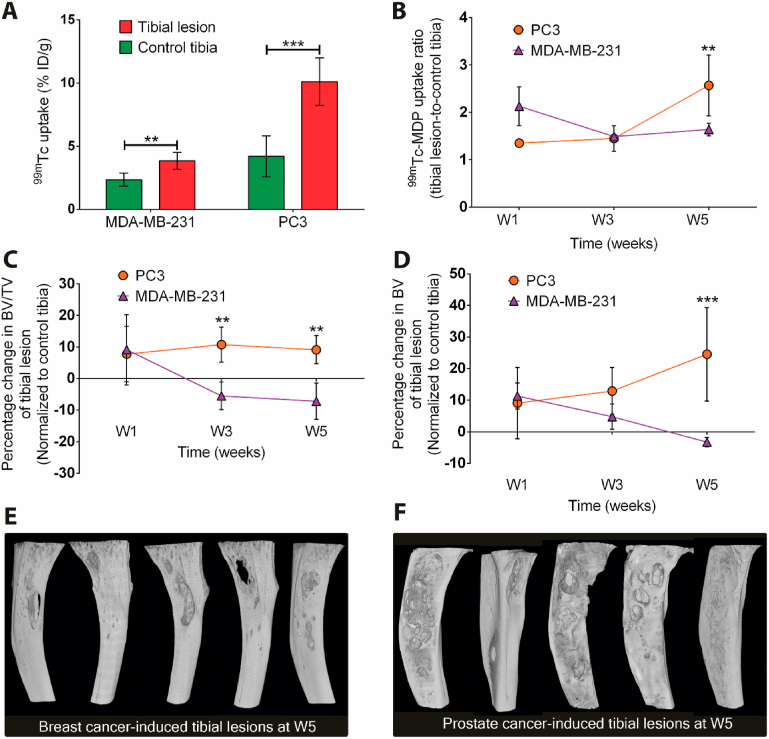
Validation of intratibial bone metastases model using micro-SPECT/CT and high-resolution micro-CT imaging. (A) Percentage of injected dose (%ID/g) of 99mTc-MDP in the tibial lesion and contralateral control tibia after W5 as quantified from the micro-SPECT/CT images. (data from 5 mice per group are presented; paired t-test; ∗∗p ​< ​0.01; ∗∗∗p ​< ​0.001). (B) 99mTc-MDP uptake (tibial lesion-to-control tibia ratio) at W1, W3, and W5 ​(data from 5 mice per group are presented; unpaired t-test; ∗∗p ​< ​0.01). Quantification of the relative change in (C) bone volume fraction (BV/TV) and (D) bone volume (BV) of tibial lesions normalized to contralateral control tibia induced by breast or prostate cancer cell intratibial injection. (two-way ANOVA with a Bonferroni posthoc test; ∗∗p ​≤ ​0.01; ∗∗∗p ​≤ ​0.001). 3D visualization of metastatic tibial lesions at W5 induced by intratibial injection of breast (E) and prostate (F) cancer cells using CTVox (Bruker MicroCT, Kontich, Belgium).